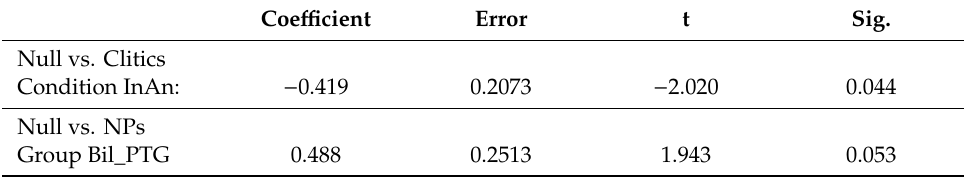
Table 5. Generalized linear mixed model (GLMM) results for immediately accessible (IA)